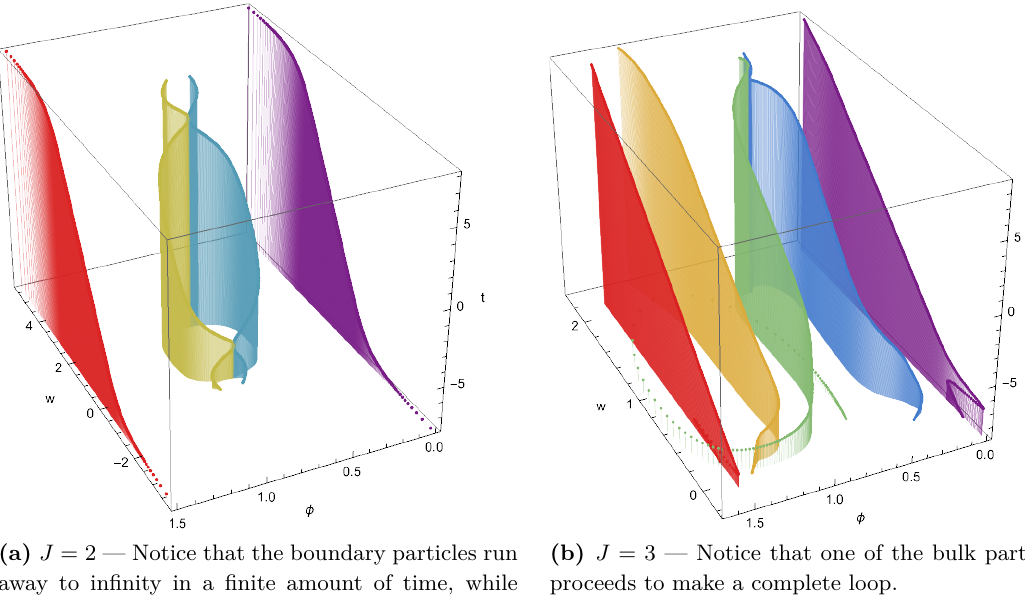
Figure 5. Plot of the motion of particles obtained by a numerical solution of the classical equations of motion. In these solutions, motion is restricted to the plane of the Wilson loop. As expected, the boundary particles are confined to fixed rays whereas the bulk particles are free to move anywhere in the